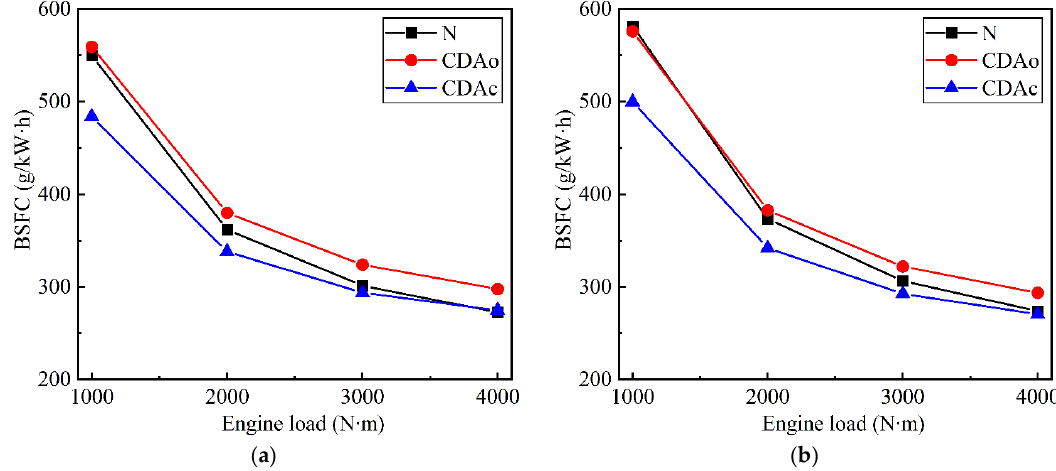
Figure 7. Comparison of BSFC for two CDA modes and the normal operation at engine torques from 1000 to 4000 N ∙ m and engine speeds: ( a ) 450 rpm; ( b ) 556 rpm (the calculated results were obtained from 1D simulation of GT-SUITE).